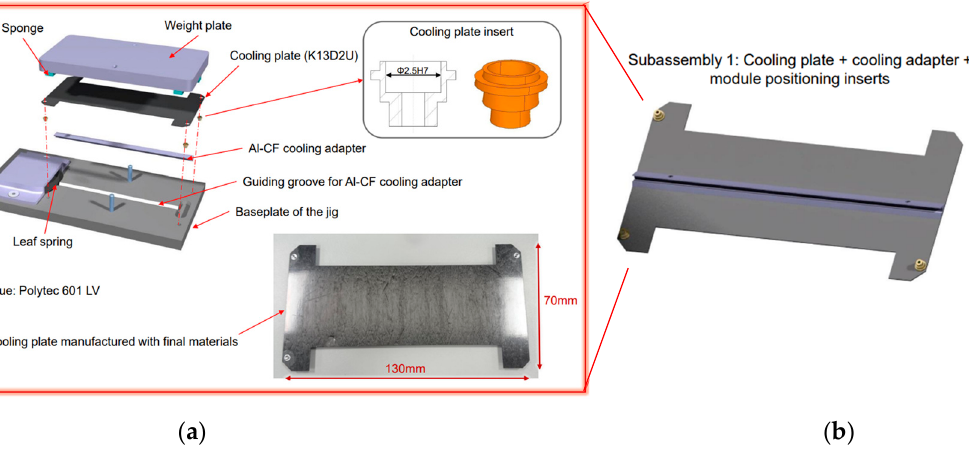
Figure 3. Supplied parts for investigation include subassemblies for the TBPS. ( a ) The details of the subassembly procedure are illustrated. The subassemblies consist of an Al/C f cooling adapter glued on a carbon-fibre/cyanate ester composite cooling plate with aluminium inserts for module positioning. ( b ) Standalone cooling adapters have also been supplied, with and without coating.